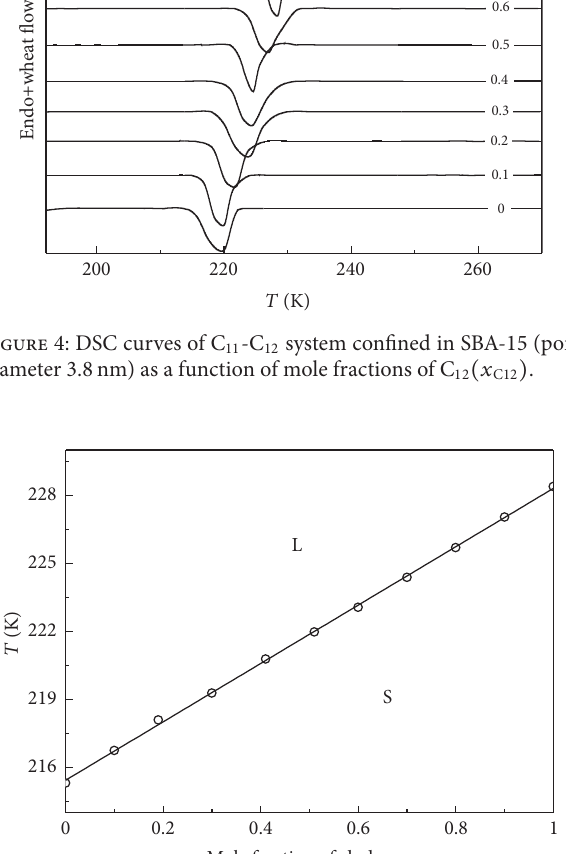
F 5: Experimental phase diagram of C in SBA-15 (3.8nm).